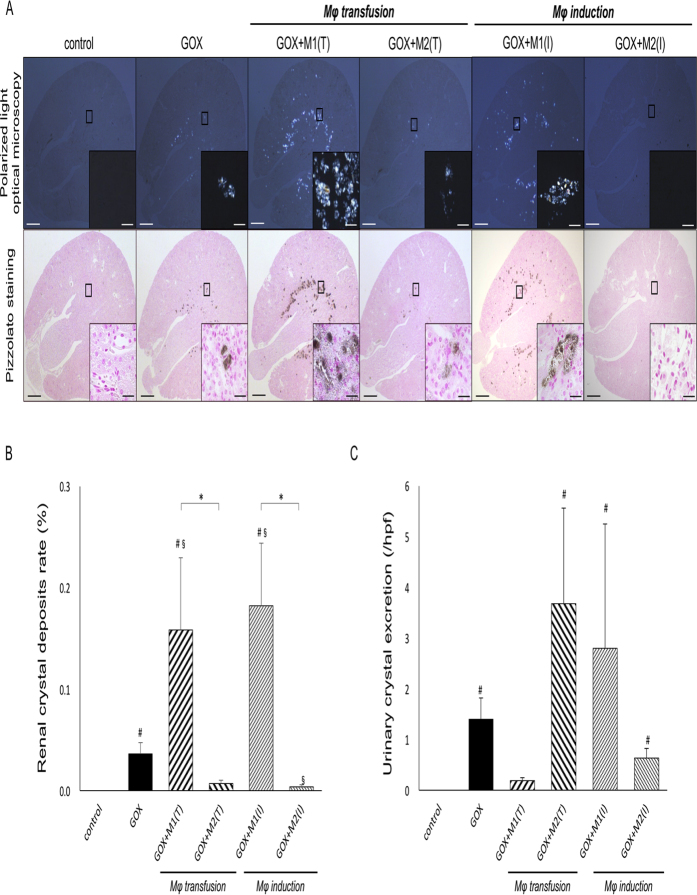
Morphological and quantitative distribution of renal calcium oxalate crystals.(A) Morphological distribution of renal calcium oxalate (CaOx) crystal deposits detected using polarized light optical microscopy and Pizzolato staining. Representative micrographs obtained at d 6. Scale bar = 500 μm; inset scale bar = 25 μm. (B) The ratio of areas with renal crystal deposition. Crystallization in each kidney section was quantified by calculating the ratio (%) of the area containing crystals to the entire kidney section using Image Pro Plus. (C) The number of urinary crystals per high-powered field. At d 6, 24-h urine samples were collected in a metabolic cage, and CaOx crystals were counted at 400× magnification. N = 6 for each group. Data are presented as means ± standard errors. *Indicates significant differences between the M1 and M2Mφ groups in the same treatment at p < 0.05; #indicates significant differences compared with the control group at p < 0.05; §indicates significant differences compared with the glyoxylate (GOX)-treated group. M1 (T) and M2 (T) indicate transfusion, whereas M1 (I) and M2 (I) induction treatment of each macrophage.